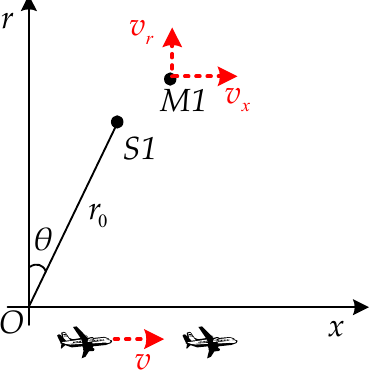
Figure 7. Point targets scene.